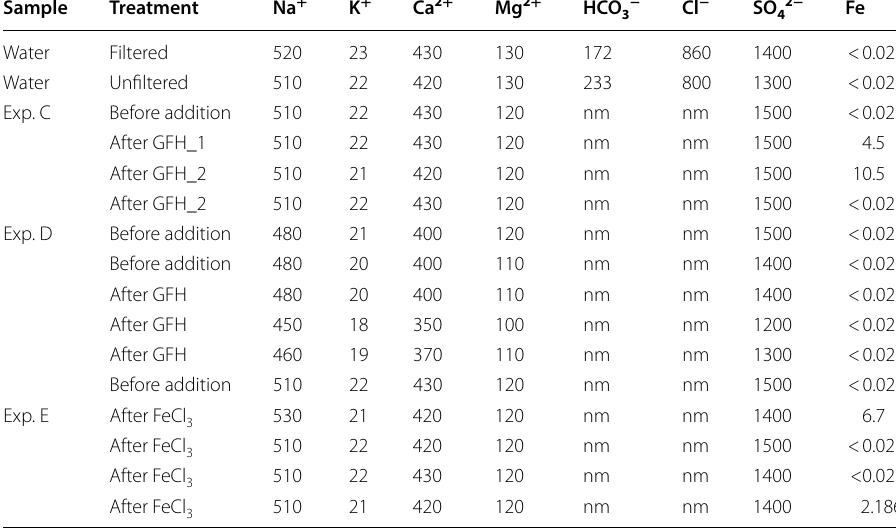
Table 5 Main cations and anion of selected water samples during experiments C, D and E